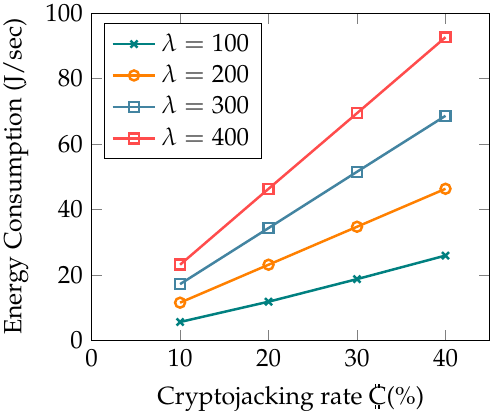
Figure 5. Cryptojacking energy consumption.